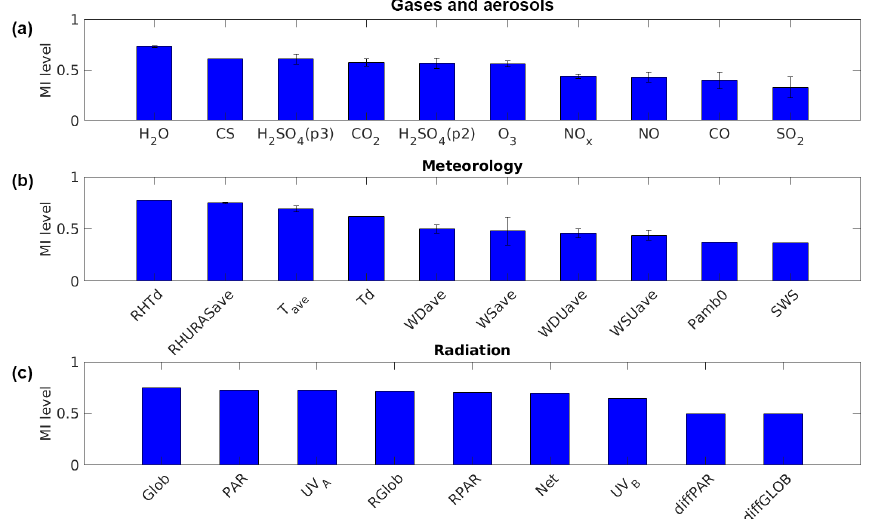
Figure 6. MI correlation level between NPF and a variety of atmospheric variables: gases concentration and aerosols (a) , meteorology (b) and radiation (c) . It can be seen that water concentration (H 2 O), condensation sink (CS), sulfuric acid (H 2 SO 4 ), relative humidity (RHTd), average temperature ( T ave ) and global radiation (Glob) are among the atmospheric variables that have strong correlation to